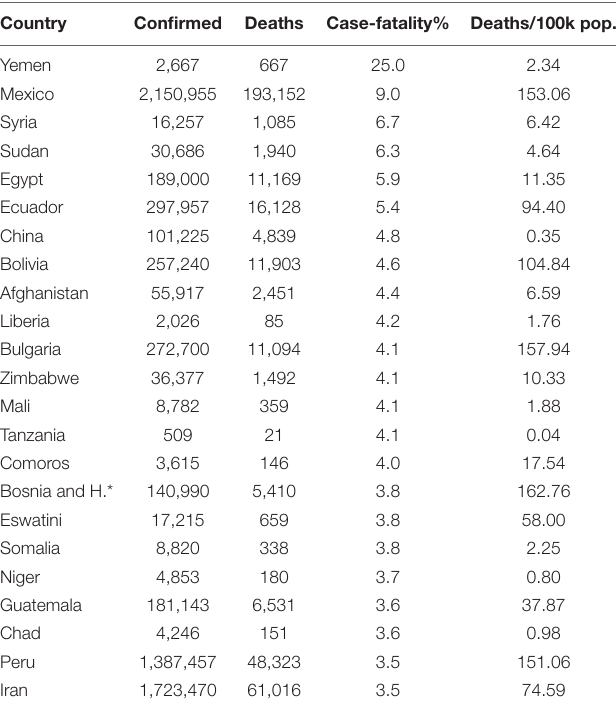
TABLE 3 | COVID-19: cases and mortality (Case-Fatality Ratio) by the most affected countries. Country Confirmed Deaths Case-fatality% Deaths/100k